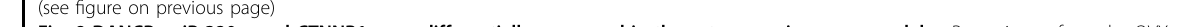
Fig. 8 DANCR, miR-320a, and CTNNB1 were differentially expressed in the osteoporosis mouse model. a Bone tissues from the OVX and sham groups were extracted and stained with H&E and Alcian Blue. b Tb.N, Tb.Th, and BMD were measured on micro-CT and dual-energy X-ray absorptiometry, respectively. c Relative expression levels of DANCR, miR-320a, and CTNNB1 in mouse bones were determined by qRT-PCR. d BMSCs from femurs and tibias in both the sham and OVX groups were isolated and cultured in osteogenic differentiation induction medium for 7 and 14 days. Cells were stained with ALP or Alizarin Red. e Cells after osteogenic differentiation induction were lysed, and qRT-PCR was performed to compare the relative expression levels of DANCR, miR-320a, and CTNNB1 in the OVX and sham groups. f Western blot analysis was performed to evaluate the protein expression of β -catenin in the cytoplasm and nucleus, TCF-1, RUNX2, OPN, and OCN of mouse BMSCs upon 7 and 14 days of osteogenic differentiation induction. All experiments were conducted independently at least three times. * P < 0.05 and ** P <